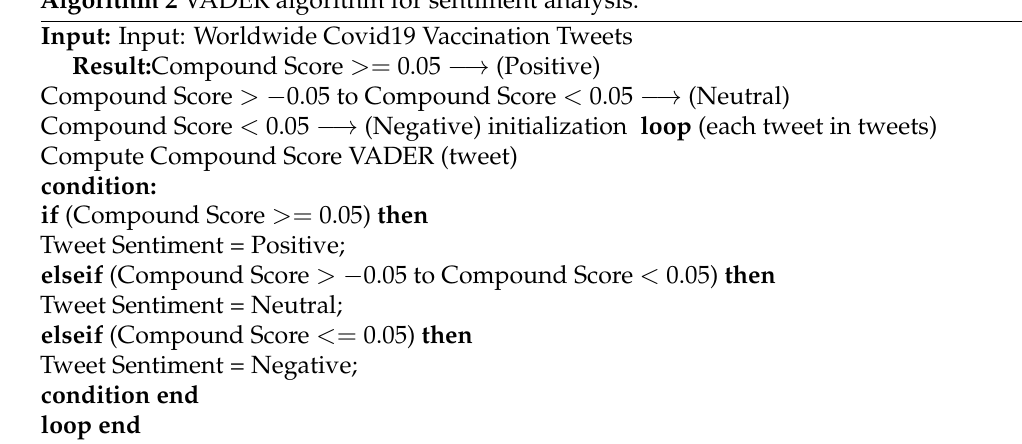
Algorithm 2 VADER algorithm for sentiment analysis.